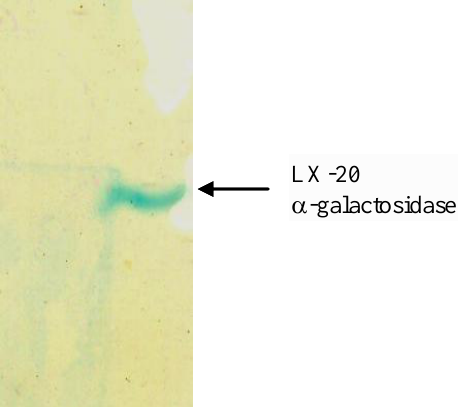
Figure 1. Zymogram analysis of  -galactosidase activity in the enzyme